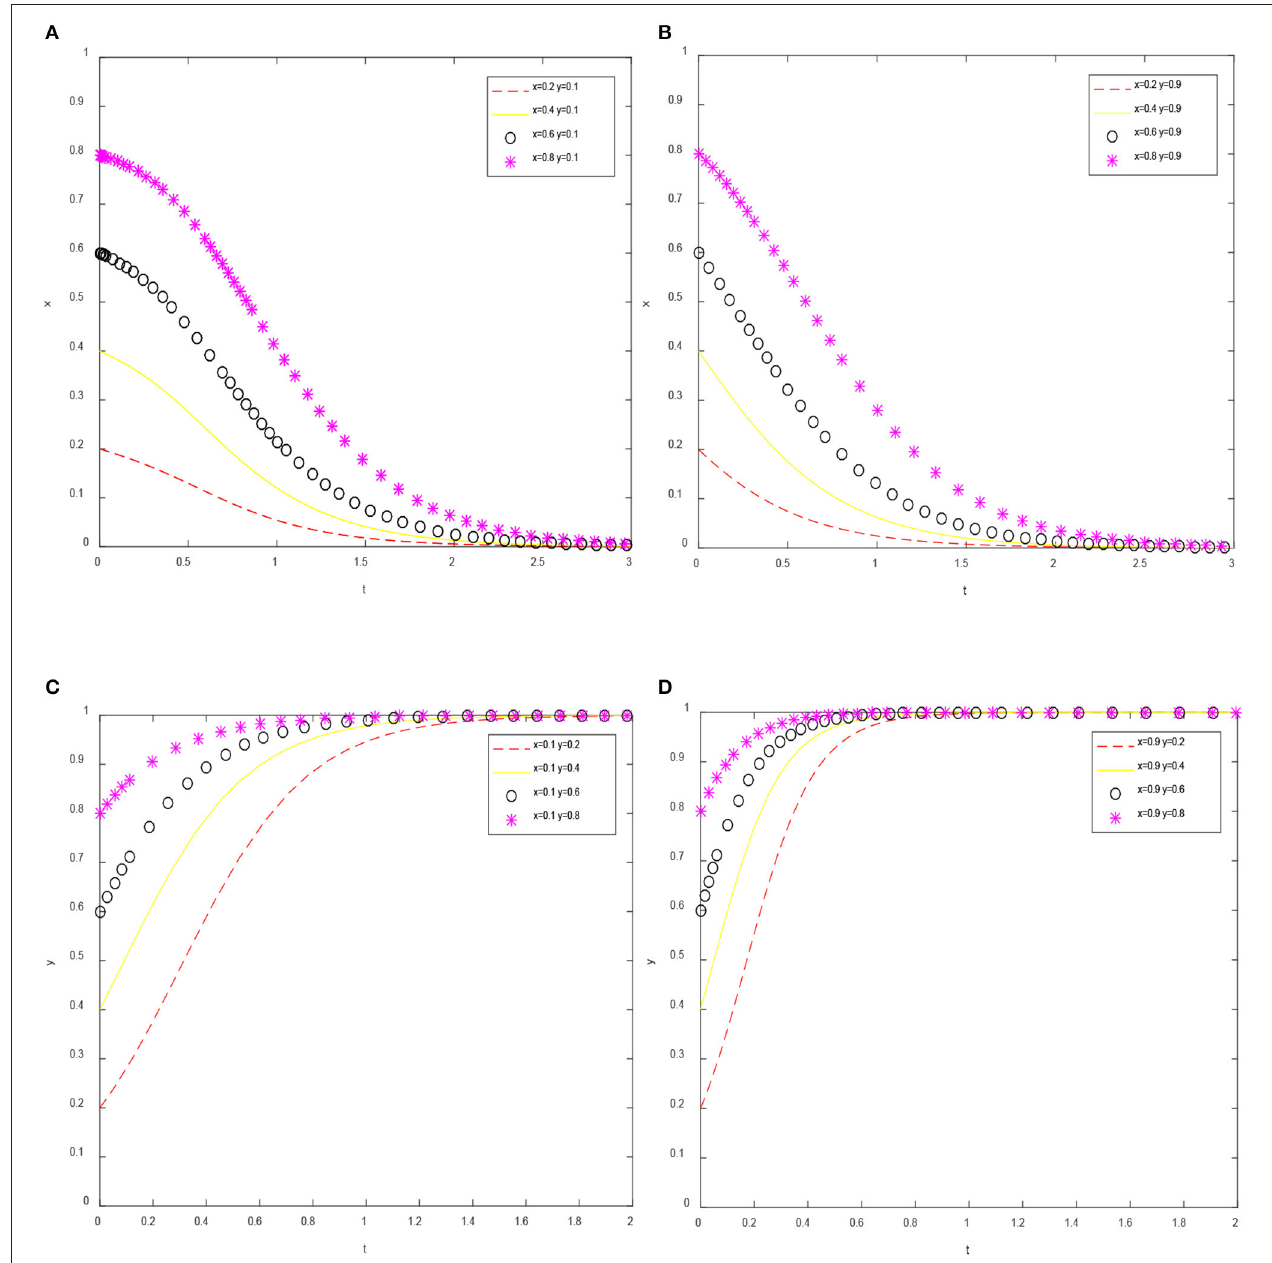
FIGURE 7 | Evolution path of the strategy of a single participant. (A) y = 0.1, (B) y = 0.9, (C) x = 0.1, and (D) x =